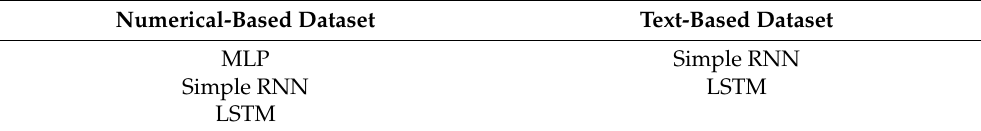
Table 7. Algorithms.